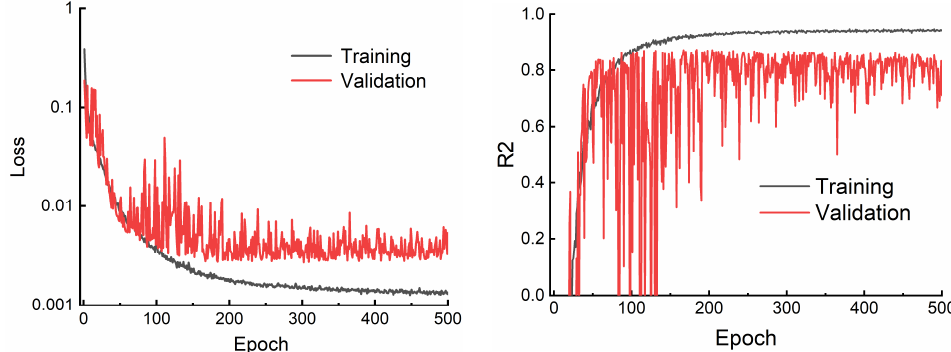
Figure 7. MSE and R 2 of the training and validation sets with elastic modulus as the label.